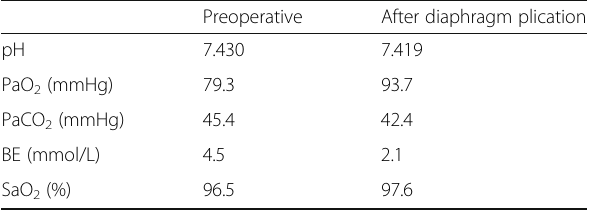
Table 2 Change in arterial blood gas (room air)